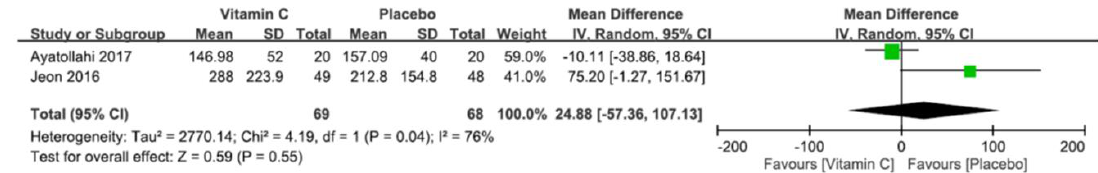
Figure 11. Forest plot for the comparison of perioperative blood loss between vitamin and placebo groups. CI, confidence interval; IV, inverse variance.